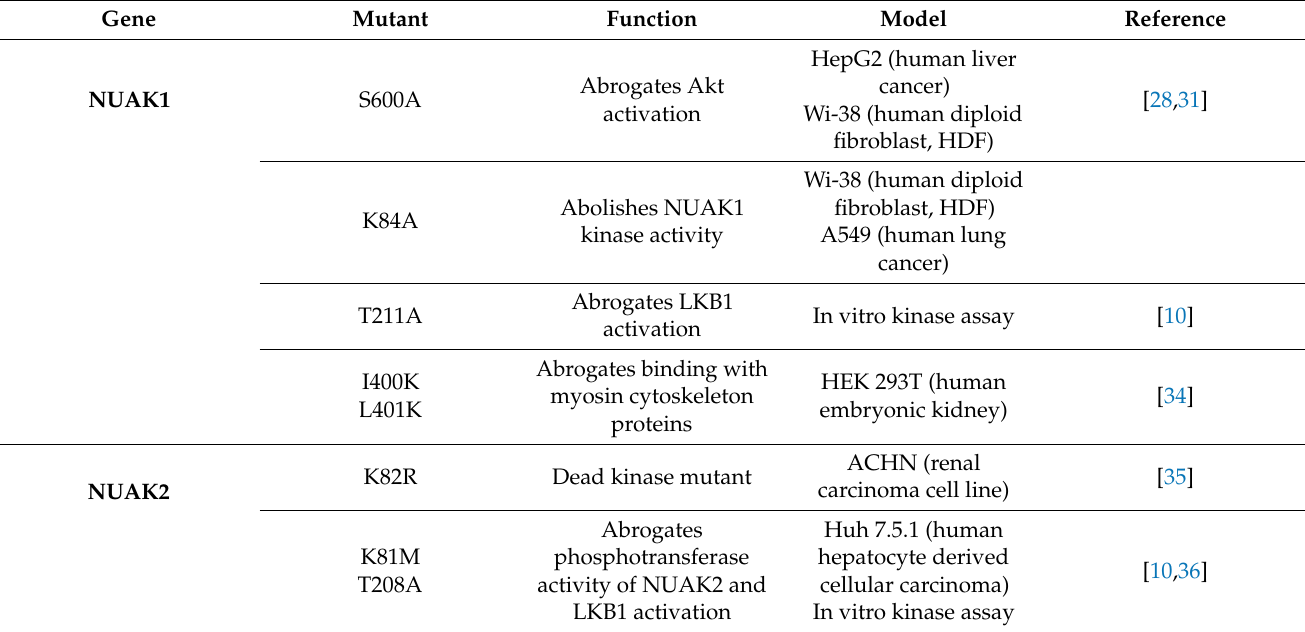
Table 1. NUAK1 and NUAK2 mutations in different cell and animal models.